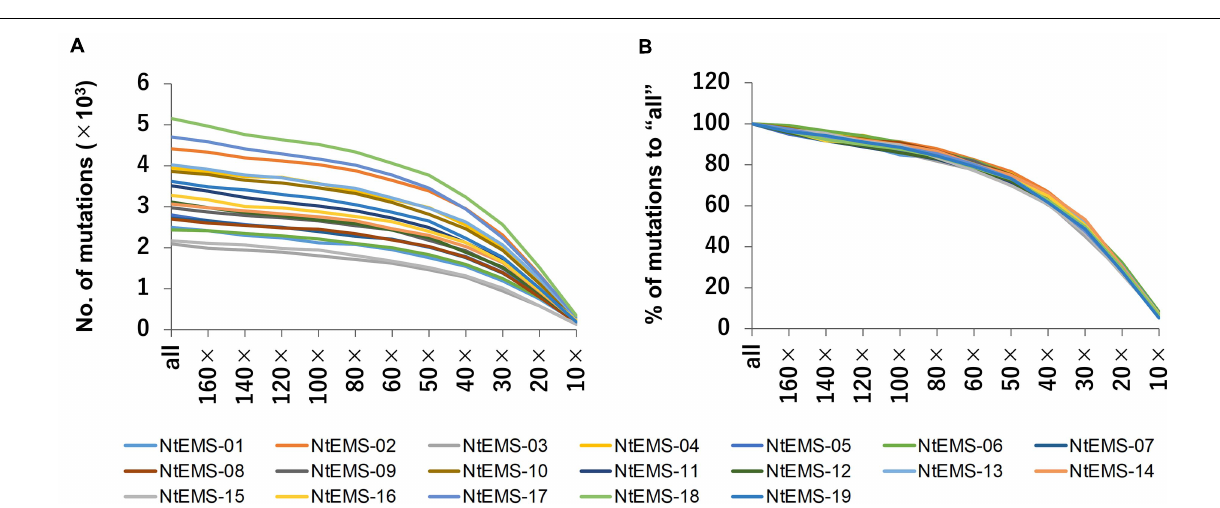
FIGURE 4 | Changes in the number of mutations with different numbers of sequence reads. All the clean sequencing reads (designated as “all”) and down-sampled sequencing reads (160 × , 140 × , 120 × , 100 × , 80 × , 60 × , 50 × , 40 × , 30 × , 20 × , and 10 × total CDS length equivalent) obtained by whole-exome sequencing were analyzed. (A) Number of mutations detected in the target regions. (B) Proportion (%) of the number of mutations detected in target regions to